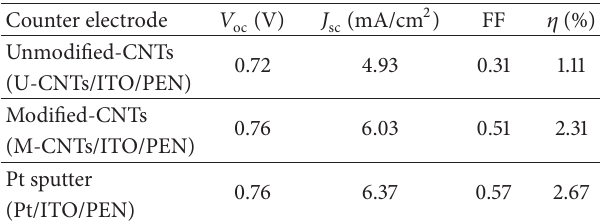
Table 3: Summary of 𝑉 , 𝐽 , FF, and 𝜂 of U-CNTs, M-CNTs, and oc sc Pt plastic